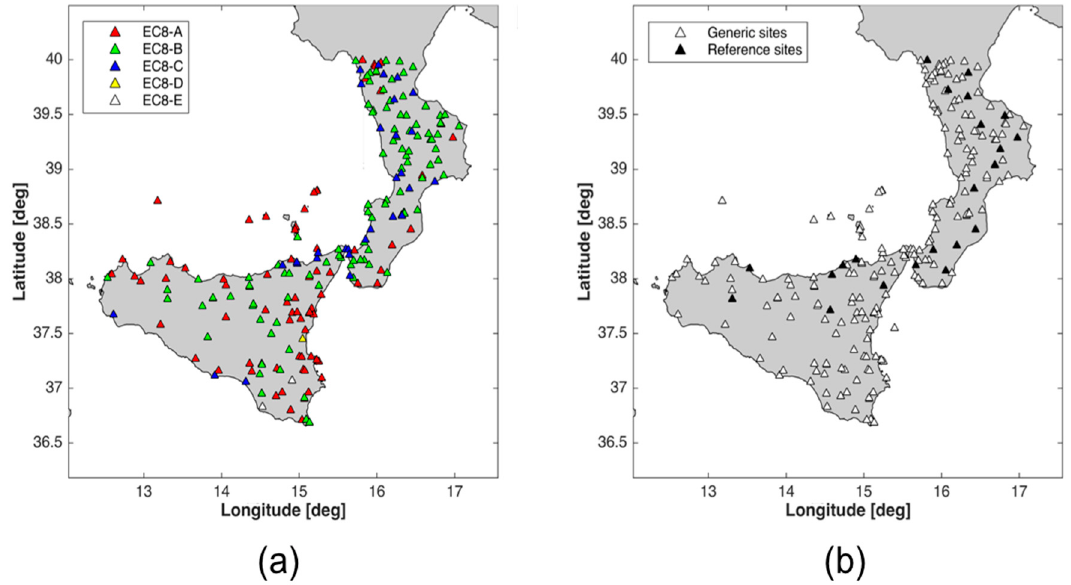
Figure 8. Maps of the recording stations plotted as a function of the EC8 code soil categories ( a ); and subdivided into reference sites (filled black triangles) and generic sites (open black triangles) ( b ).